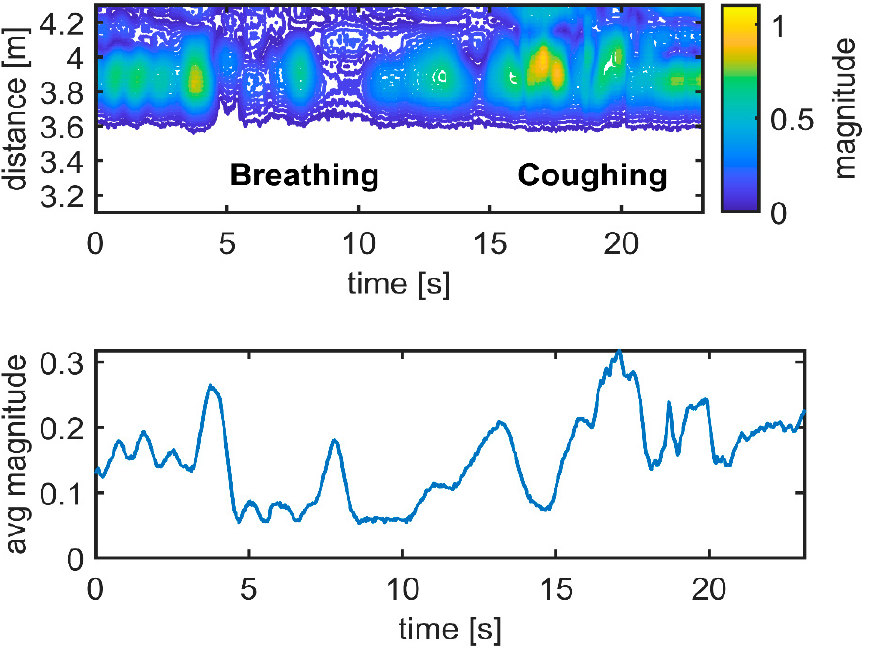
Figure 10. Respiration and coughing. Experimental results: standing frontside. Magnitude unit [ µ V] is normalized.